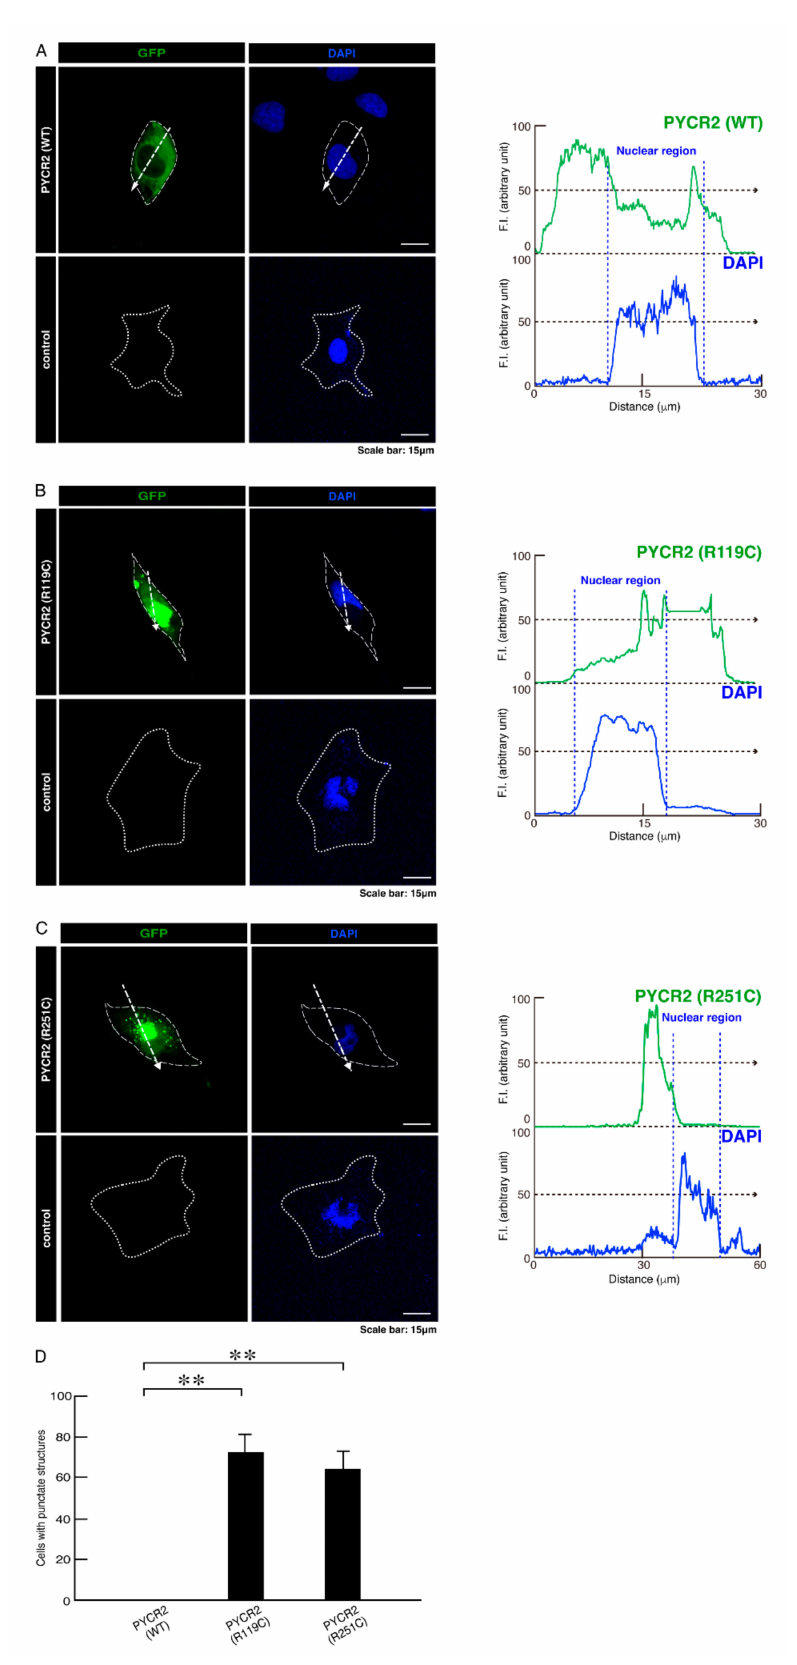
Figure 1. The PYCR2 R119C and R251C mutated proteins, but not the wild type PYCR2 proteins, exhibit structures like large size aggregates or organelles in cells. ( A – C ) COS-7 cells were